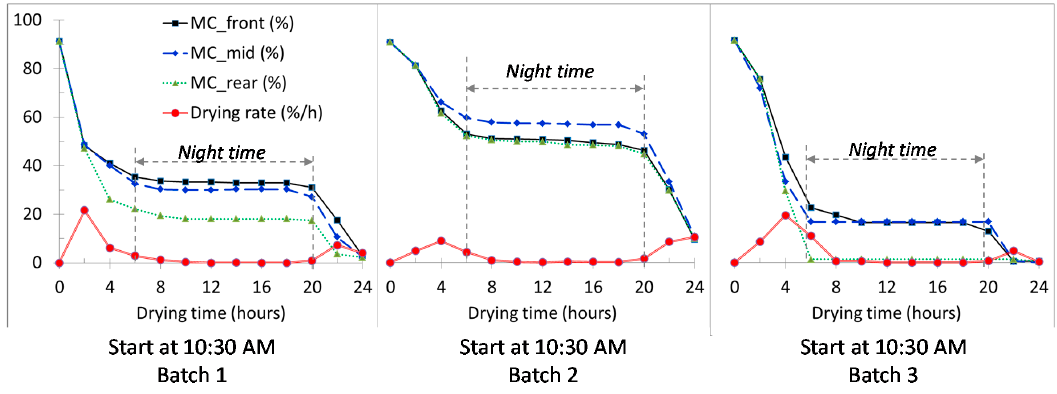
Figure 4. Profile of mushroom MC reduction and drying rate at 3 positions (front, middle, rear) along the SBD during the 3 drying batches.